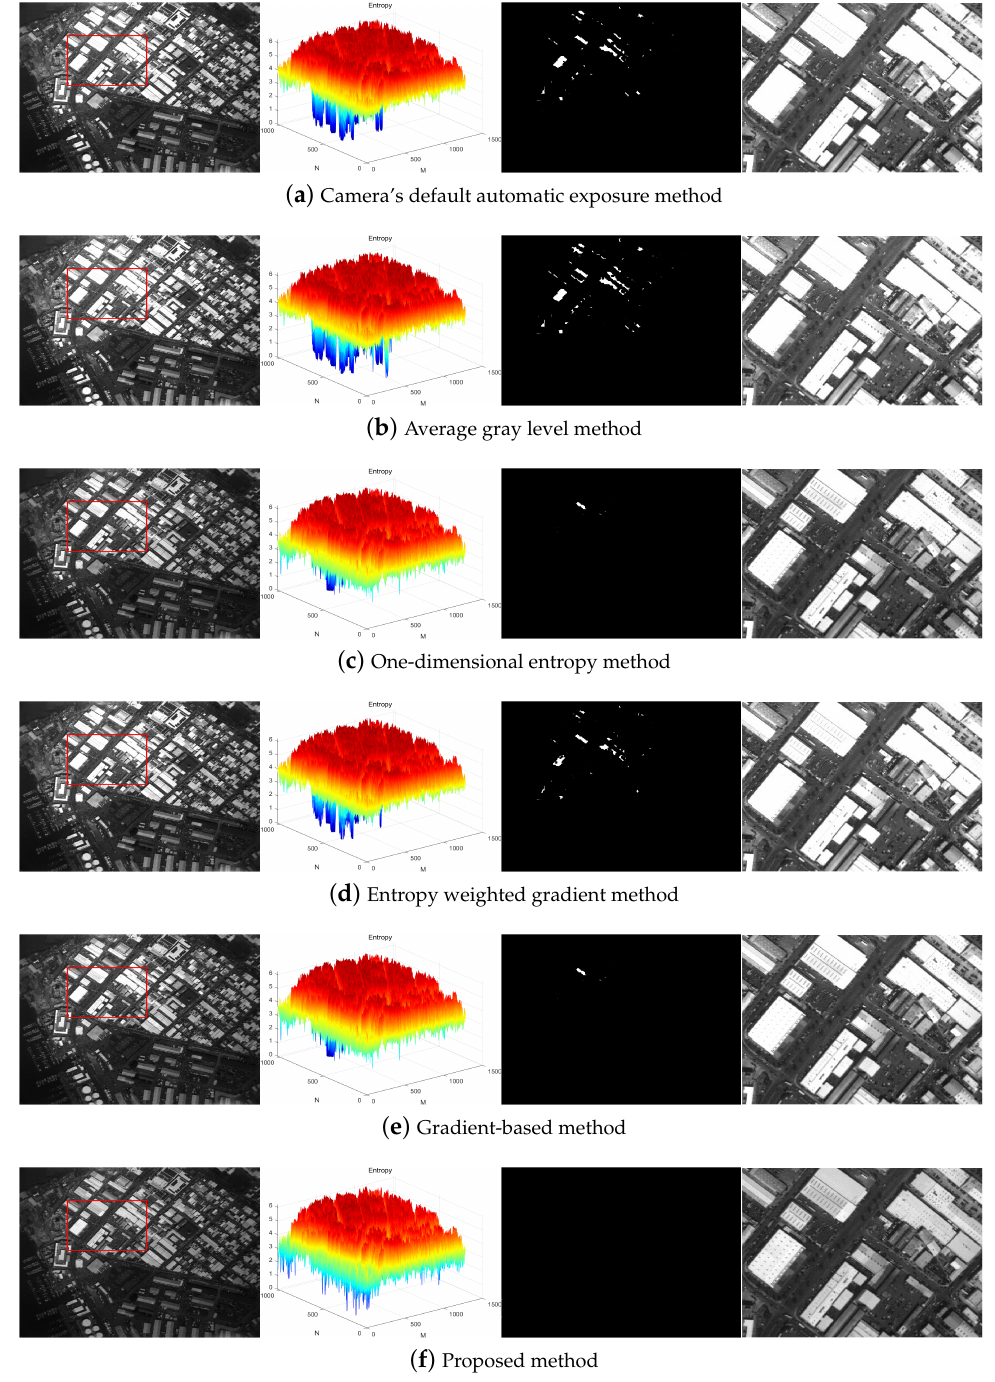
Figure 5. The optimal exposure image, the three-dimensional image entropy matrix, segmentation of ROS, and the enlarged view of the labeled region of each method under dark conditions from left to